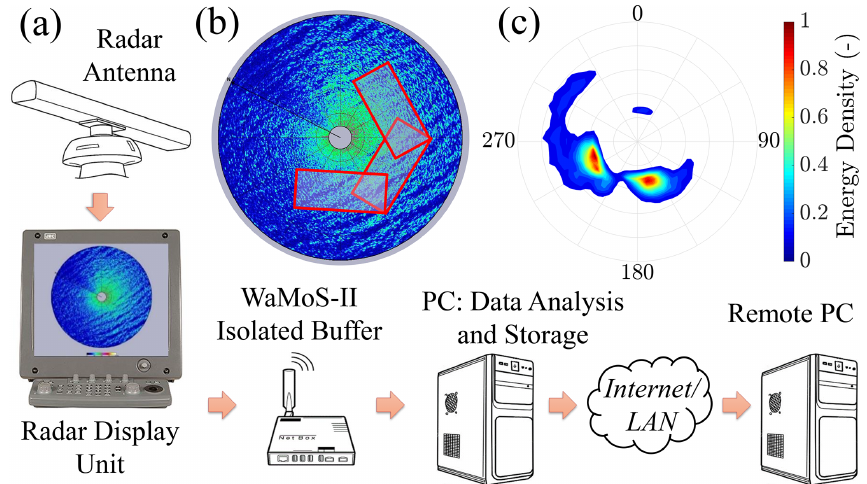
Figure 3. Schematic of the wave and surface current monitoring system WaMoS-II (a) , example of radar imagery and sub-areas (not in scale) for post-processing (b) , and a sample-derived directional wave energy spectrum (c)